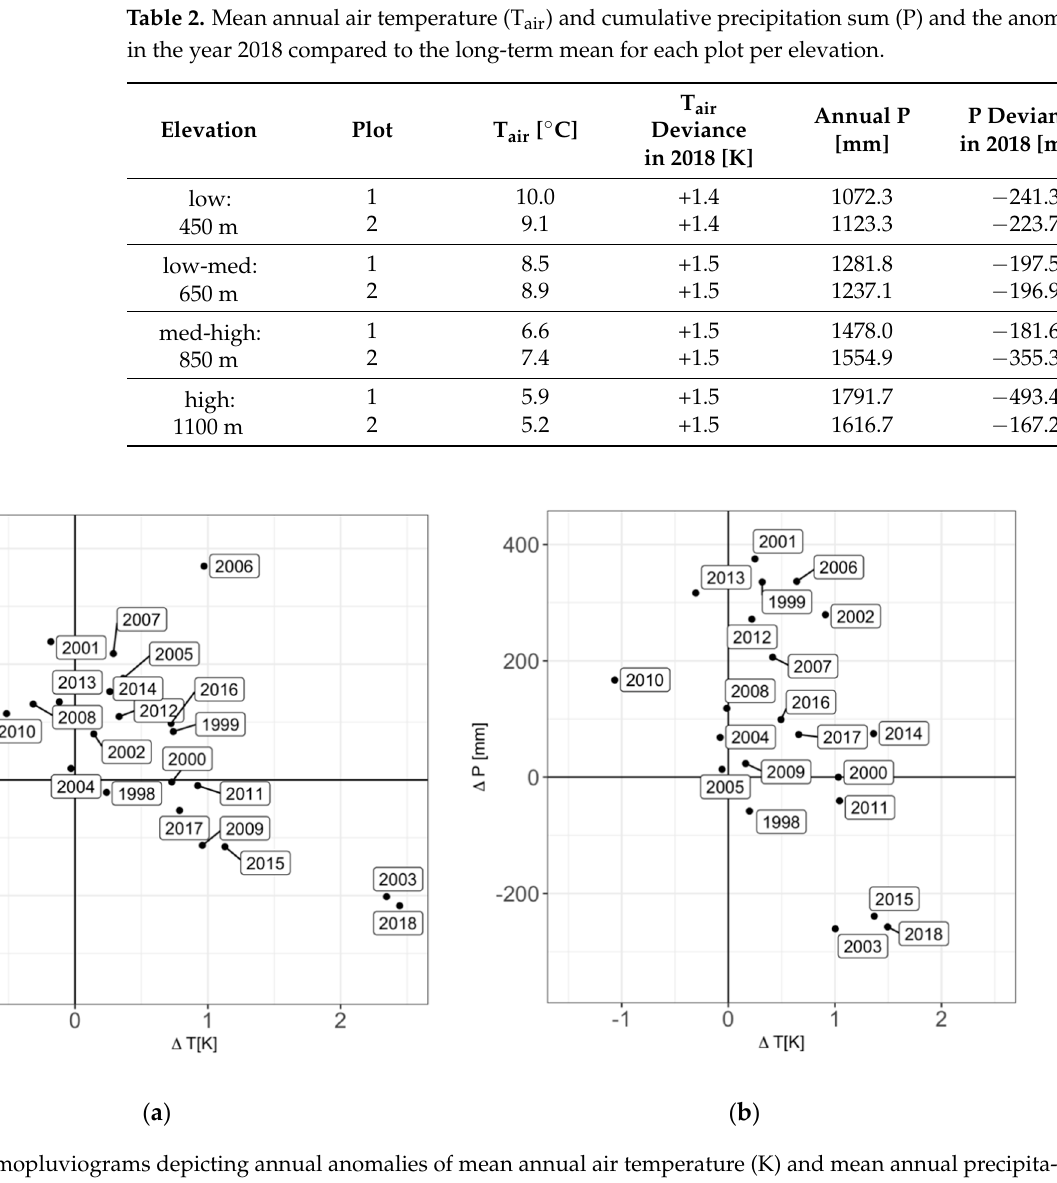
Table 2. Mean annual air temperature (T air ) and cumulative precipitation sum (P) and the anoma- lies in the year 2018 compared to the long-term mean for each plot per elevation.